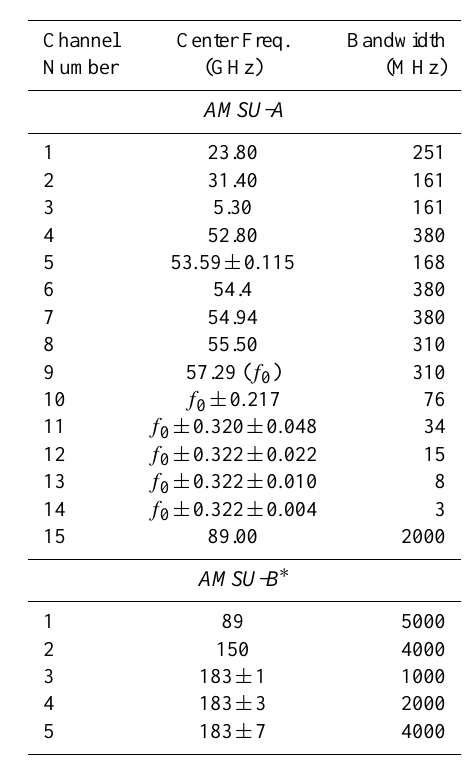
Table 1. Frequencies and Band Width of AMSU-A and B